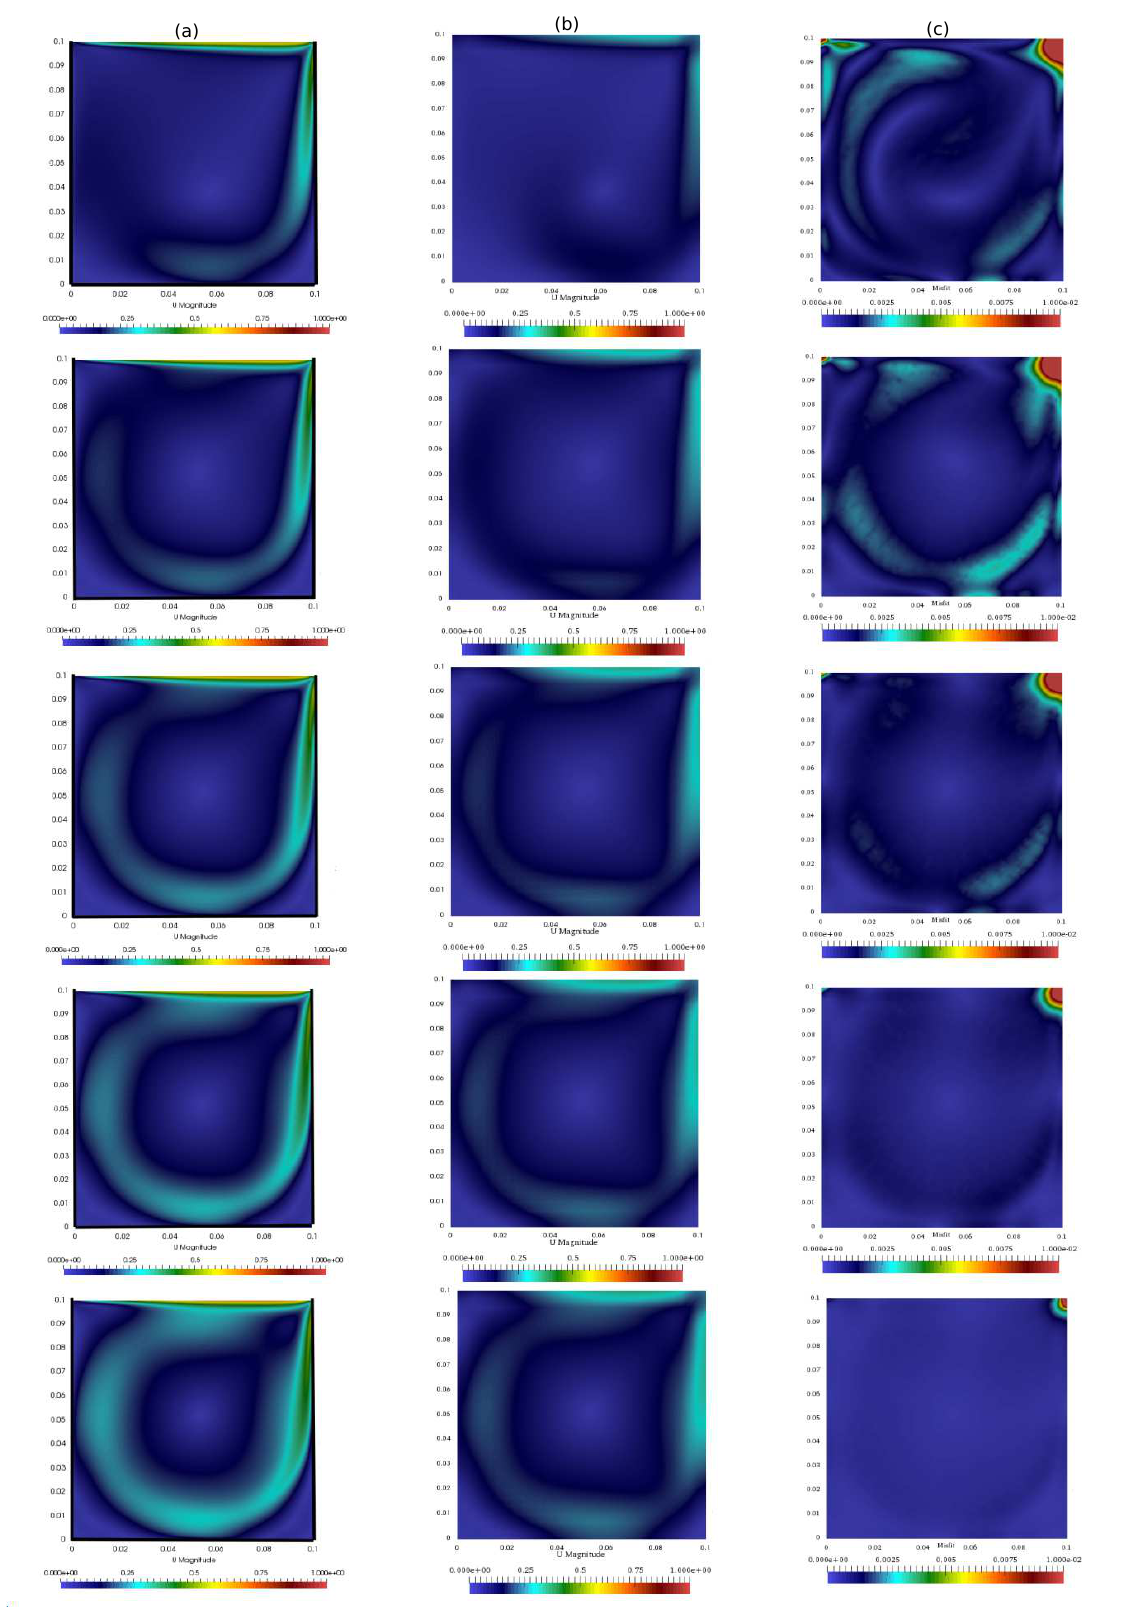
Figure 4. Contours of the velocity of the coupled algorithm with: the Kalman filter ( a ); the standard PISO algorithm ( b ); and the difference between the time solutions of the filter and of the standard algorithm computed on the finest mesh ( c